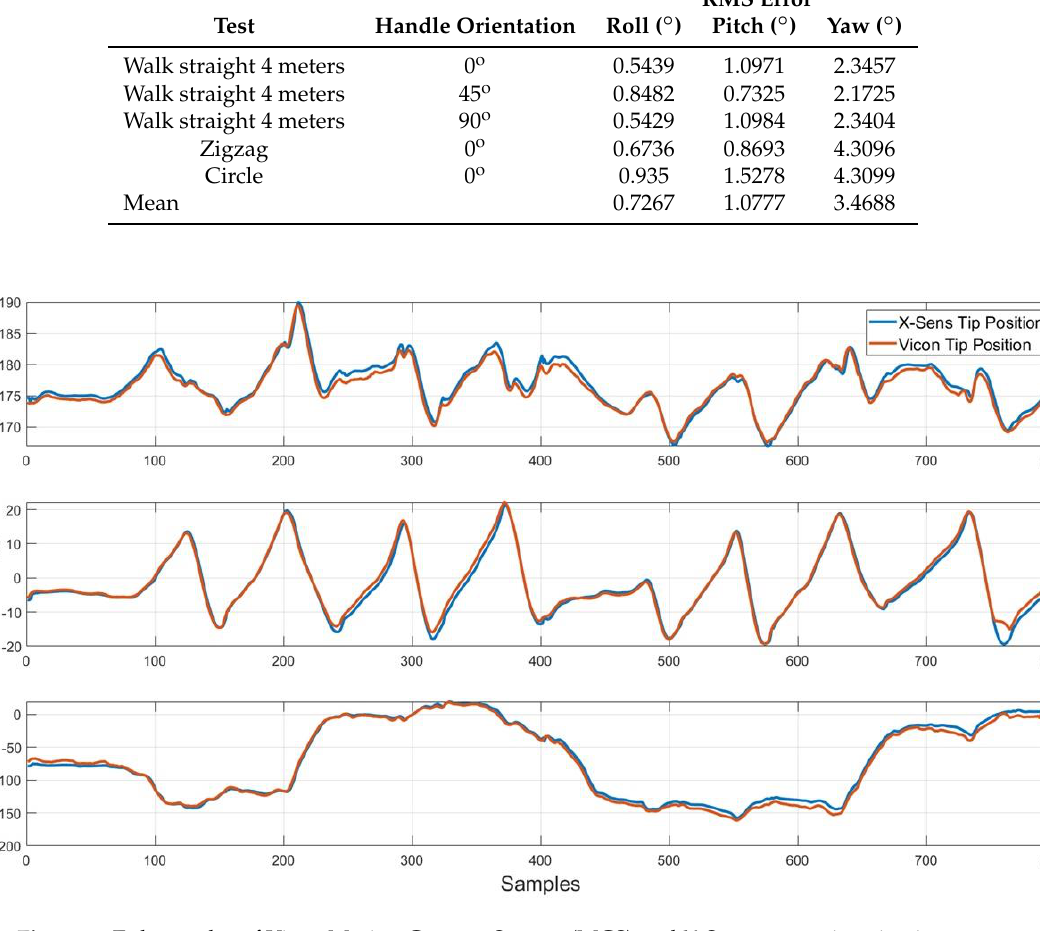
Figure 5. Euler angles of Vicon Motion Capture System (MCS) and X-Sens comparison in zigzag